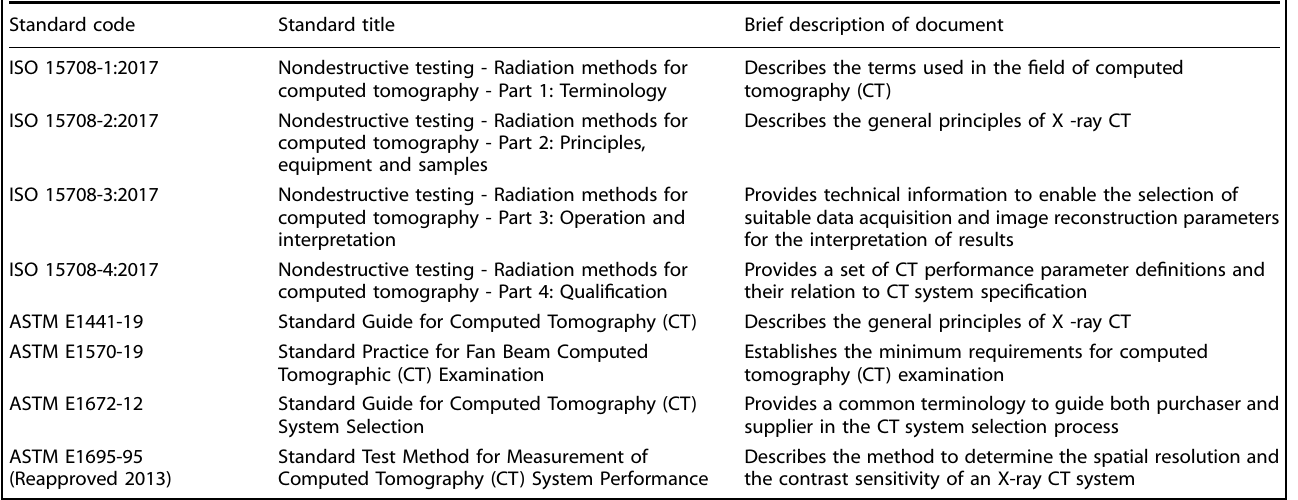
Table 5. Published standards applicable to computed tomography